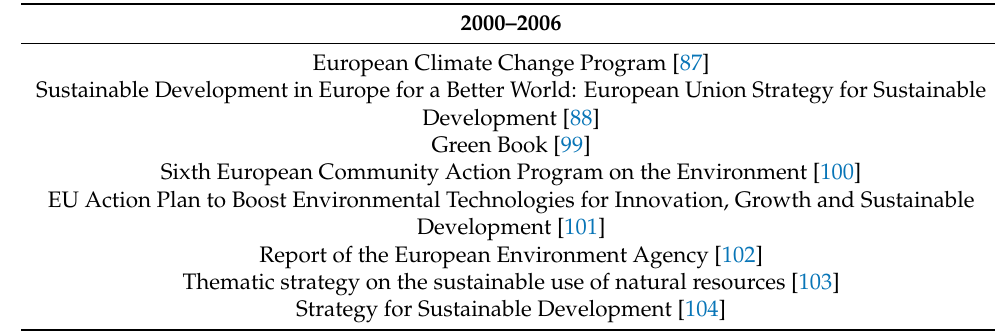
Table 7. Legislation of the European Union from 2000 to 2006.